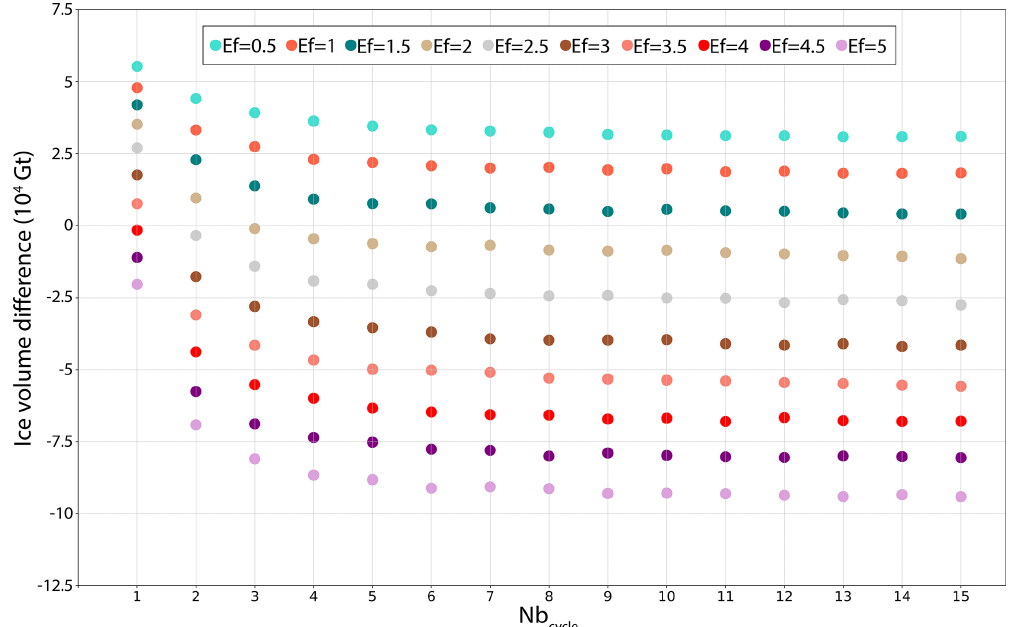
Figure 8. GrIS volume difference with regard to observations from Bamber et al. (2013), in gigatons, for Nb inv = 20 years and Nb free = 200 years and with enhancement factors (Ef) ranging from 0.5 to 5, as a function of the number of iterations (Nb cycle ).